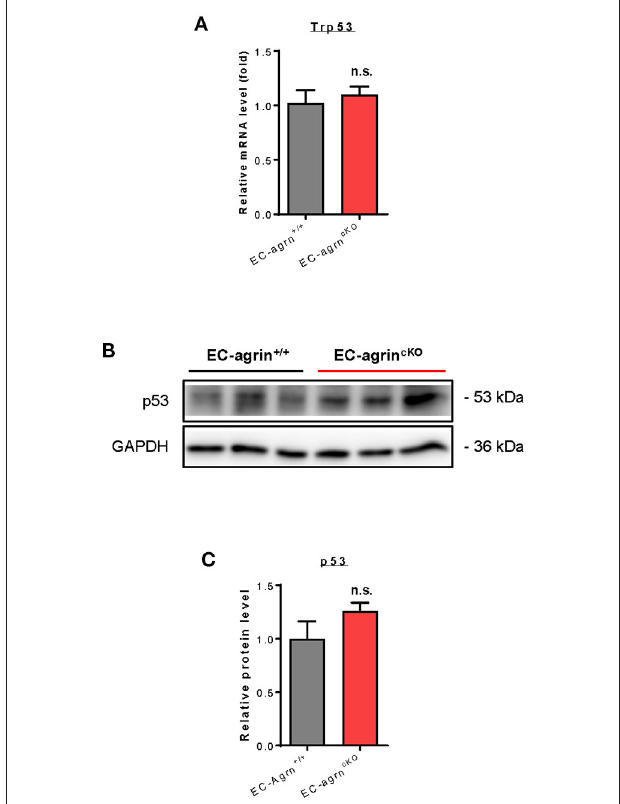
FIGURE 7 | Agrin does not regulate endothelial p53 mediated activation in vivo. (A) RT-qPCR analysis showing no significant difference in expression levels of Trp53 gene after endothelial loss of agrin in vivo . (B,C) Western blotting analysis showing no significant difference in endothelial expression of p53 after endothelial loss of agrin in vivo . (A,C) Data are presented as mean ± S.E.M., n = 3, differences were determined by ANOVA and Turkey’s HSD post-hoc test, n.s. denotes no significant